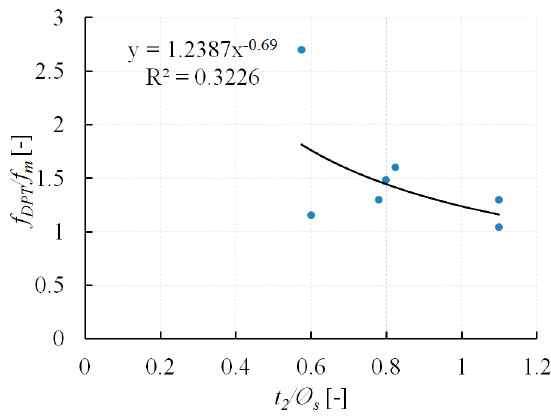
Figure 9. Relation between specimen slenderness ( t 2 / Ø s ) and value f DPT / f m .